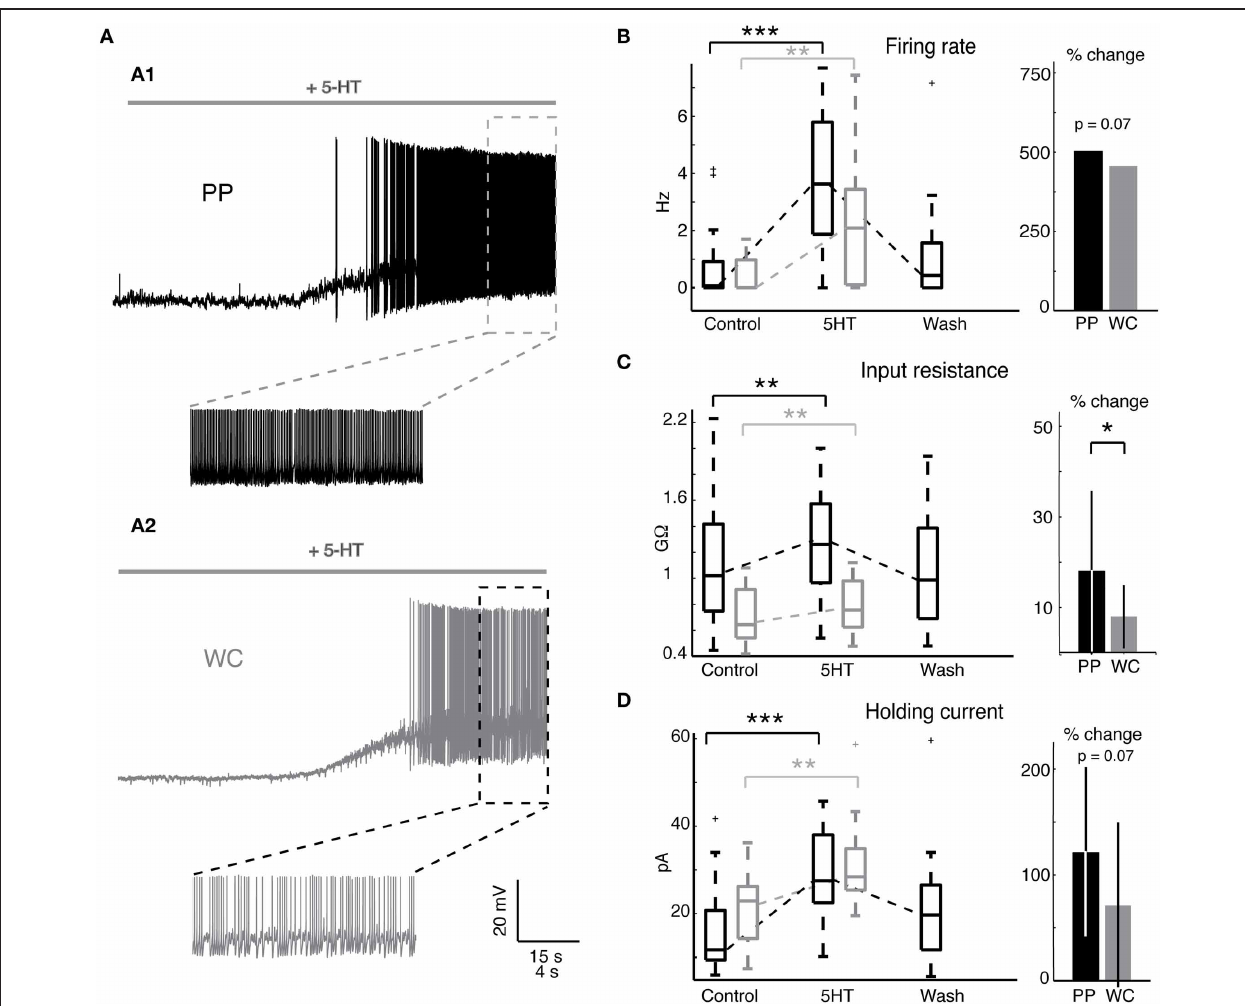
increase for individual cells cannot be calculated for those cells starting with a firing rate of zero.) (C) Serotonin increased the input resistance of both PP and WC neurons. The increase in PP cells was significantly larger than the change in WC cells. ( D) Both PP and WC excited cells depolarized in response to 5-HT, and therefore required an increased holding current to hyperpolarize them to − 60mV. The increase in holding current was significant for each, but the amount of change was not significantly different between the